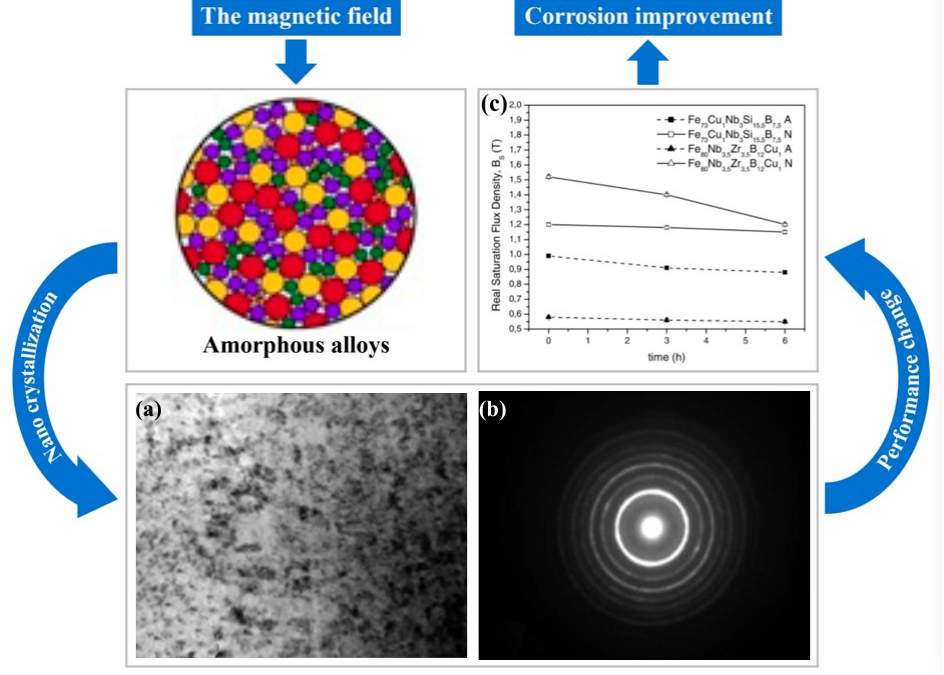
Figure 28. Images of Fe52Co34Hf7B6Cu1 after pulsed magnetic field treatment with nano-crystallization of the workpiece, adapted with permission from Ref. [192] 2006, Elsevier. ( a ) TEM micrograph of Fe52Co34Hf7B6Cu1. ( b ) Distinct diffraction rings are generated. It can be determined that the samples are nano-crystallized after the pulsed magnetic field treatment. ( c ) The values of saturation magnetic flux density, Bs, as function of the immersion time in corrosive environment (0.1 M of H2SO4 solution) for amorphous (A) and nanocrystalline (N) samples, adapted with permission from Ref. [195] 2002, Elsevier. Corrosion enhancement was obtained for both Fe73Nb3Si15.5B7.5Cu1 and Fe73.5Cu1Nb3Si15.5B7.5 after nano-crystallization.